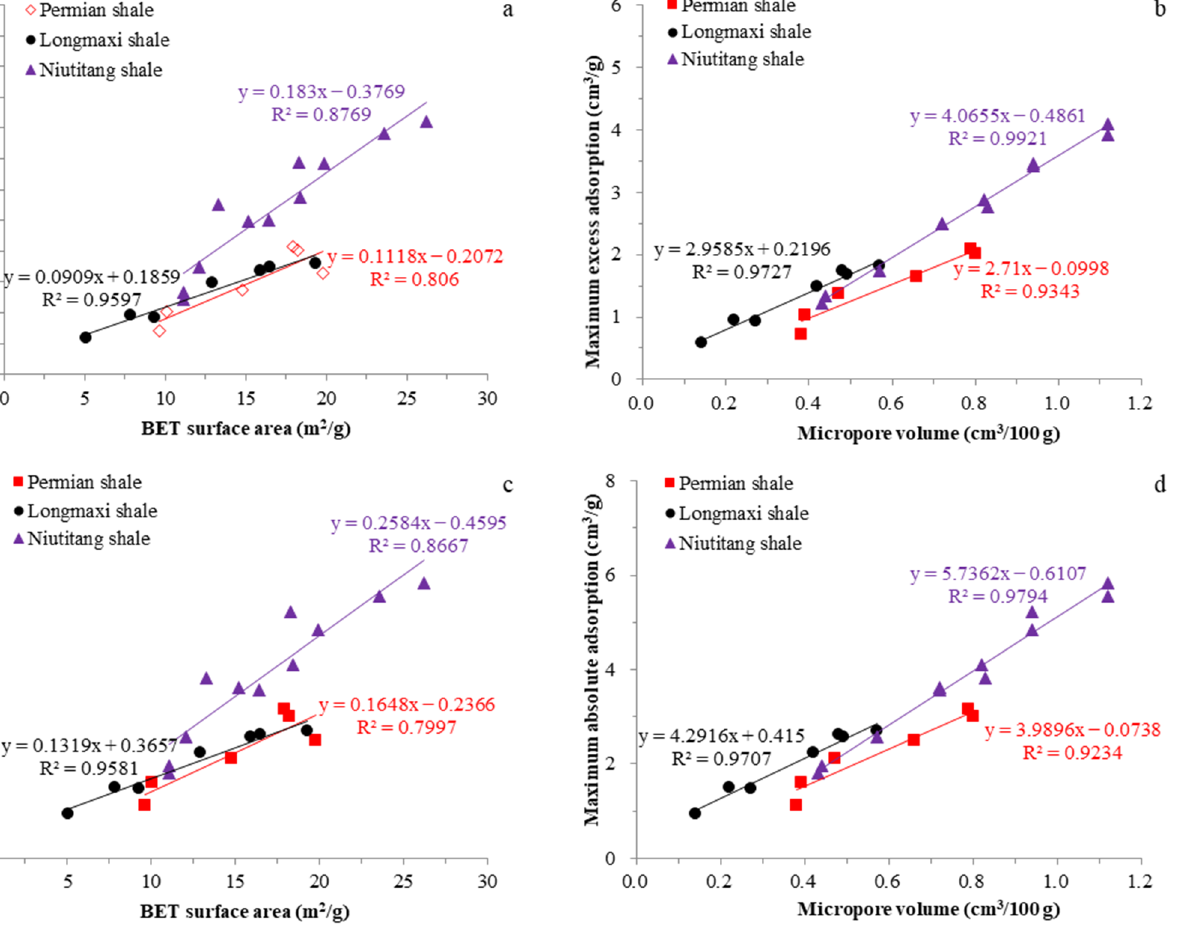
Figure 6. Plots showing the relationships between the maximum adsorption with the BET surface area ( a , c ) and the micropore volume ( b , d ) for the studied samples. (The Longmaxi and Niutitang shales are from Pan et al. [8] and Li et al. [14], respectively).